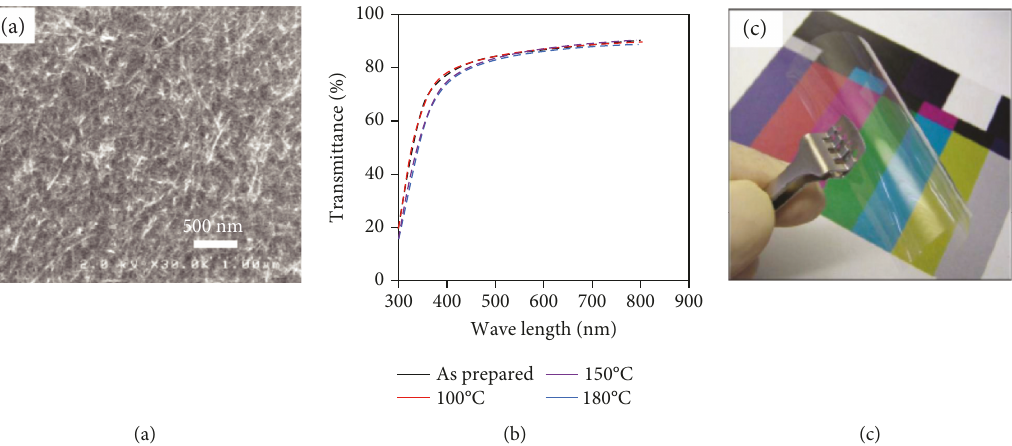
Figure 3: (a) Scanning electron microscopy image of CNF nanopaper. Scale bar: 500nm. (b) Transmittance spectra of nanopaper: as prepared (black); cured at 100 ° C (red); cured at 150 ° C (violet); cured at 180 ° C (blue). Nanopaper retained excellent light transmittance after curing. (c) Appearance of a 20 μ m thick transparent CNP after 180 ° C curing. Reproduced from reference [23] with permission from John Wiley & Sons.